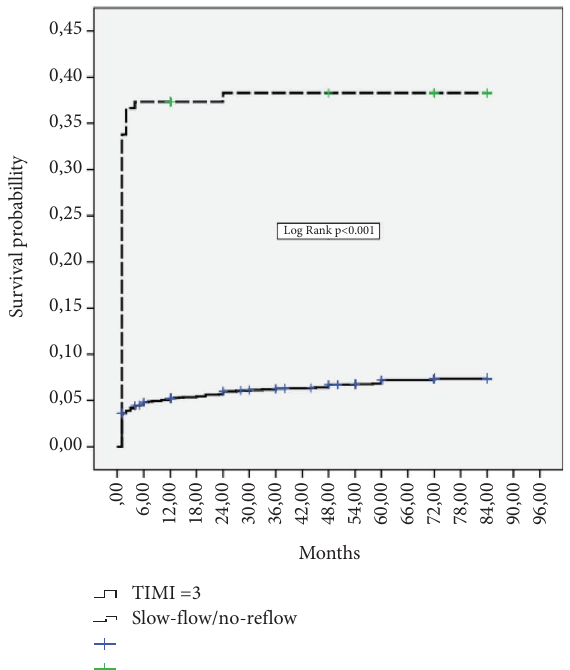
Figure 1: Kaplan–Meier curves showing mortality during an eight-